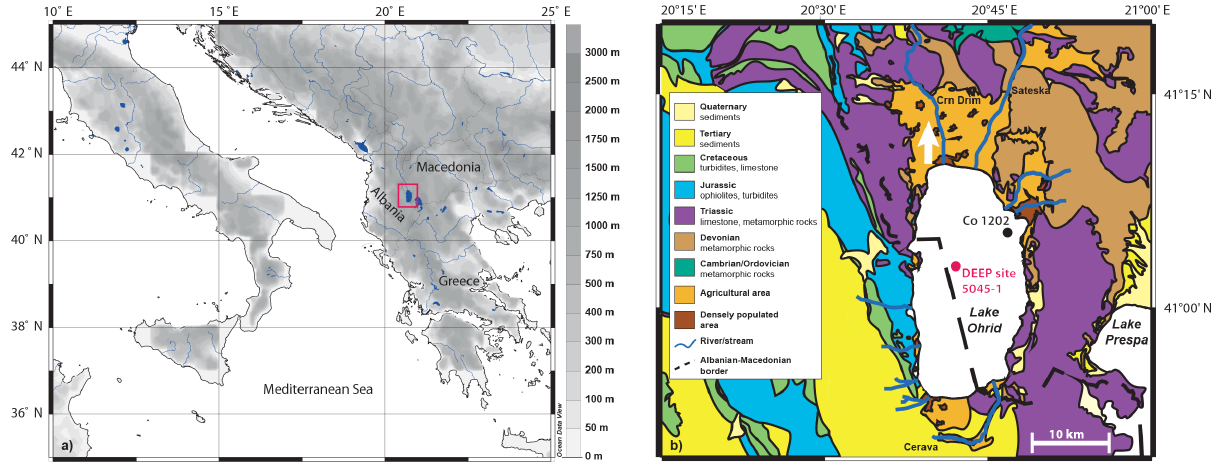
Figure 1. (a) Overview map of the Balkan Peninsula. (b) Geological map of the Lake Ohrid region and coring locations of the DEEP site (5045-1) and Co1202 (Vogel et al., 2010a). Modified after Vogel et al.